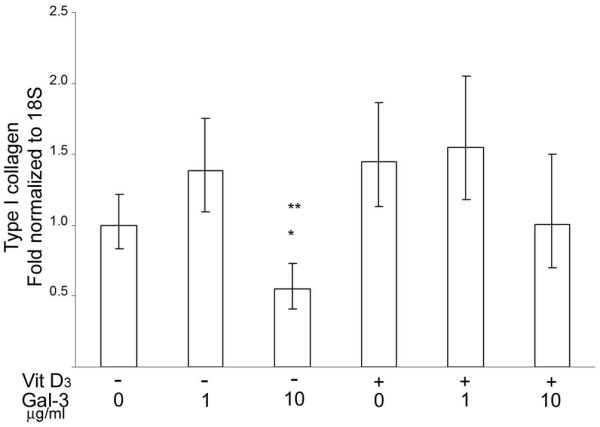
Effects of exogenous galectin-3 (gal-3) on type I collagen expression in osteoblasts. Osteoblasts were treated with 1 or 10 μg/ml of recombinant human gal-3 in the presence or not of vitamin D3. Collagen type I α1 chain expression was analyzed by real time RT-PCR. *P versus control (Ctl; without vitamin D3 or gal-3); **p versus 1 μg gal-3 alone; n = 4.